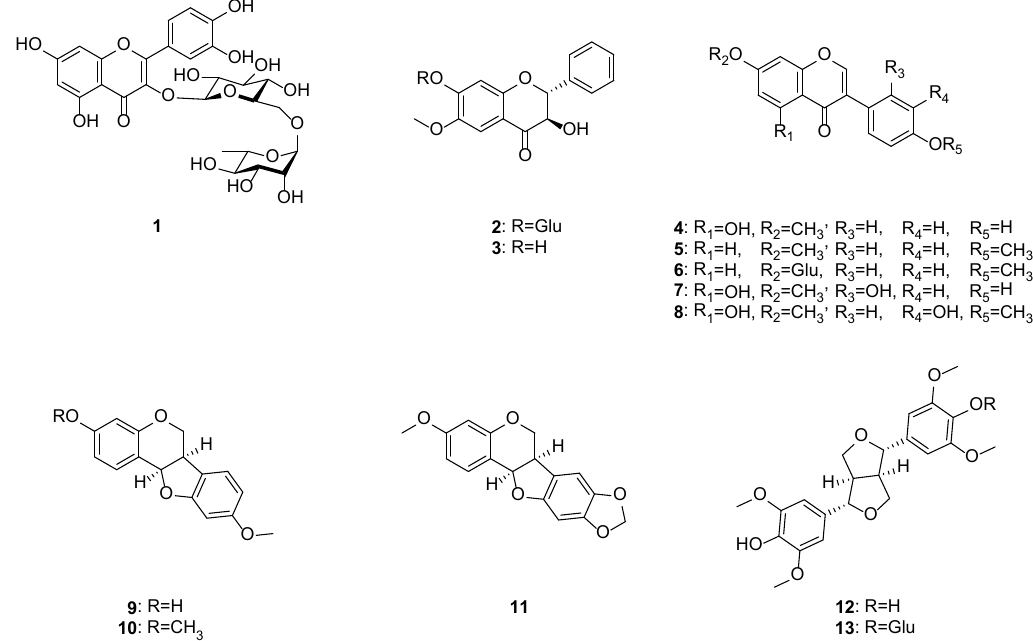
Figure 1. Chemical structures of compounds 1 – 13 obtained from C. lineata pods.